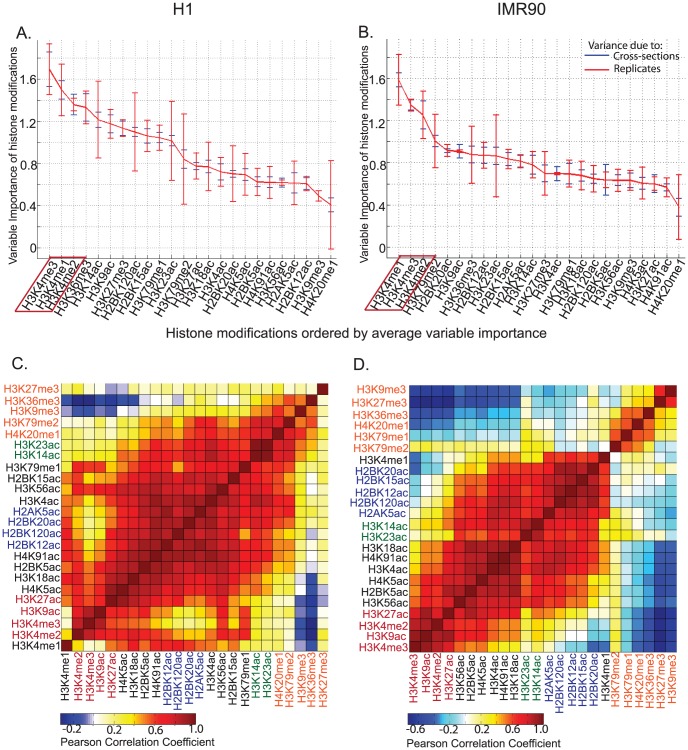
Out-of-bag variable importance of histone modifications in enhancer prediction.The average variable of histone modifications across 5 cross-sections of data in 2 sets of replicates as well as averaged replicates using all 24 modifications in A.)H1 and B.)IMR90 cells. Out-of-bag variable importance was calculated from the random-forest based classification of p300 binding sites against TSS+genomic background. Robust appearance of H3K4me1, H3K4me3 and H3K4me2 among the most important marks across replicates and cell types, indicates these may form a minimal set for prediction of enhancers. Differences observed in correlation clustering of the same 24 modifications in C.)H1 and D.)IMR90 explain some of the differences in ordering of variables in the two cell types. Same non-black colors of modifications indicate clusters that co-occur in both cell-types.